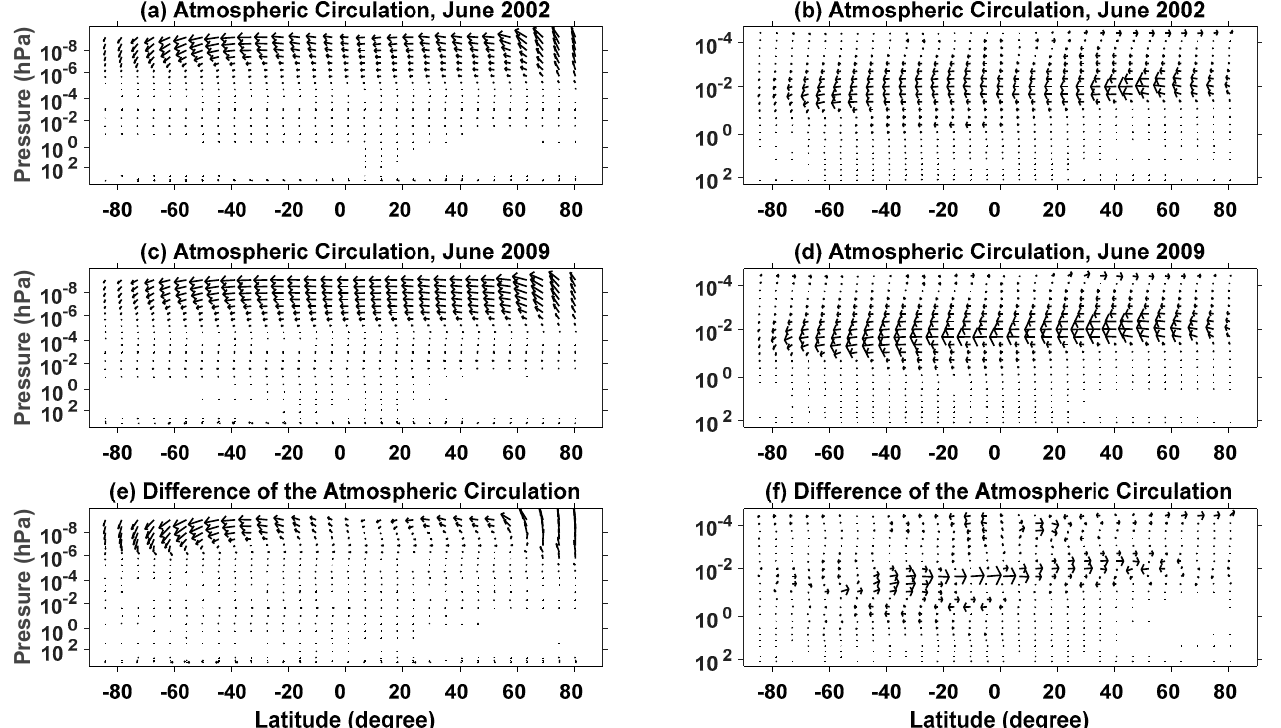
Figure 7. Atmospheric circulation in June ( a , b ) 2002 and ( c , d ) 2009. ( e , f ) Differences in the atmospheric circulation in June between 2002 and 2009. Left and right panels show the atmospheric circulation in the global atmosphere and in the middle and lower atmosphere, respectively.